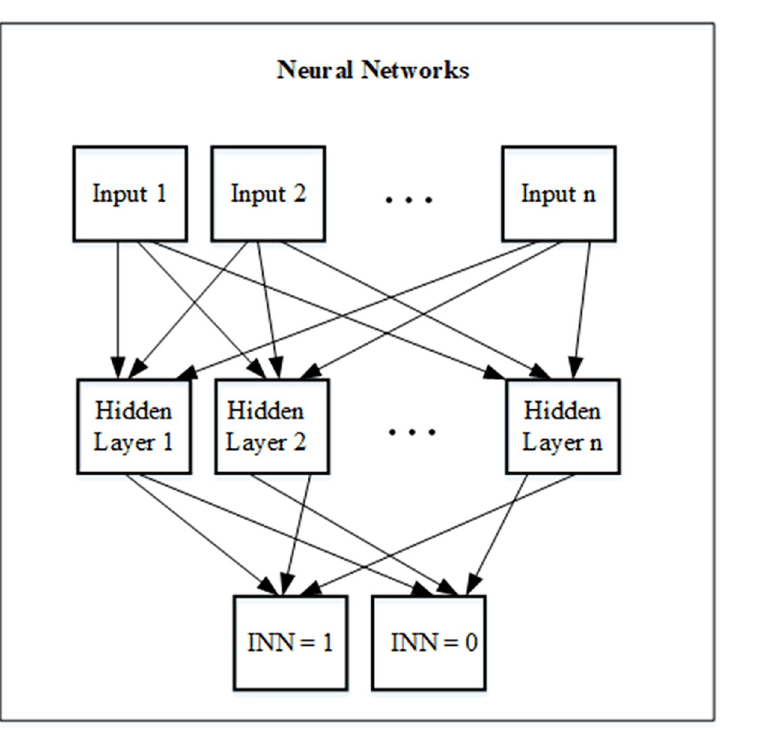
Fig 2. Proposed neural networks